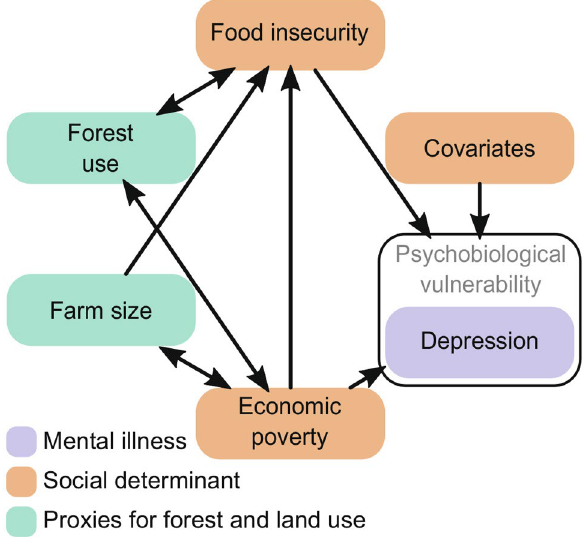
Figure 2. An illustration of the hypothesised links between farm sizes and forest use (proxies for nature’s contributions), food insecurity and depression (social determinants) and depression risk (mental illness) in the case study site. Single-headed arrows describe correlations, and bi-directional arrows describe